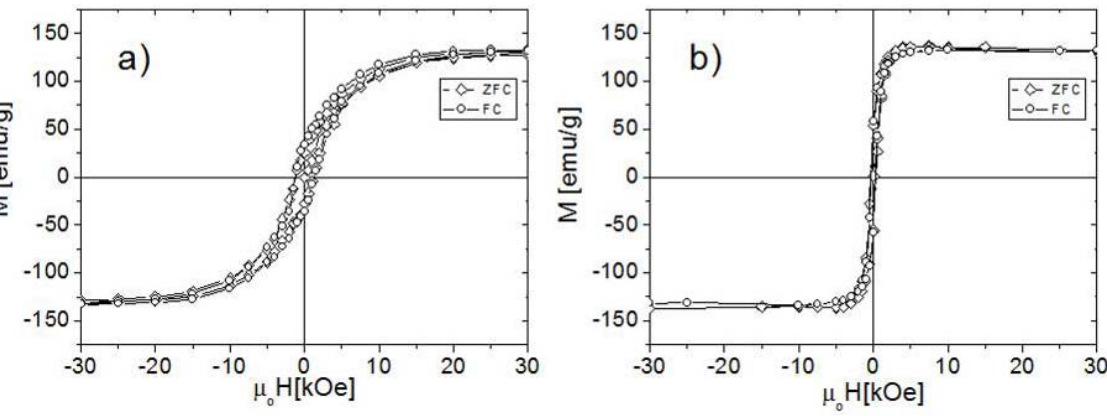
Figure 7. Hysteresis loops after Zero field Cooling (ZFC) and Field Cooling (FC, H = 5T) ( a ) at 2 K relative to the sample obtained in situ with Boba:HDA:Co = 0.65:1:1 (d = 14 ± 2 nm, Figure 5(a)) ( b ) at 300 K relative to the sample obtained in situ with Boba:Co =1 (d = 10 ± 2 nm, Figure